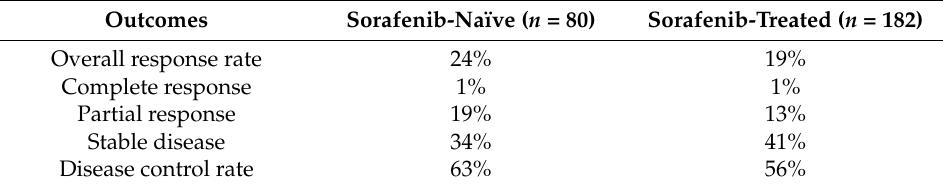
Table 5. Results of a clinical study to investigate nivolumab in advanced hepatocellular carcinoma. Outcomes Sorafenib-Naïve ( n = 80) Sorafenib-Treated ( n = 182) Overall response